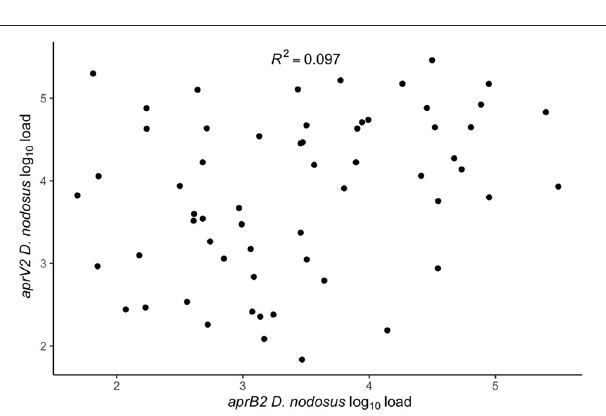
FIGURE 5 | Within swab association between aprV2 D. nodosus log 10 load and aprB2 D. nodosus log 10 load from 60 samples positive for both aprV2 and aprB2 D. nodosus from 3 visits (1–3) to 24 flocks in England with clinical footrot. The correlation coefficient ( R 2 ) was calculated using the built-in lm function in R Studio Version 3.6.0 (39) to calculate a simple linear regression. P -value =